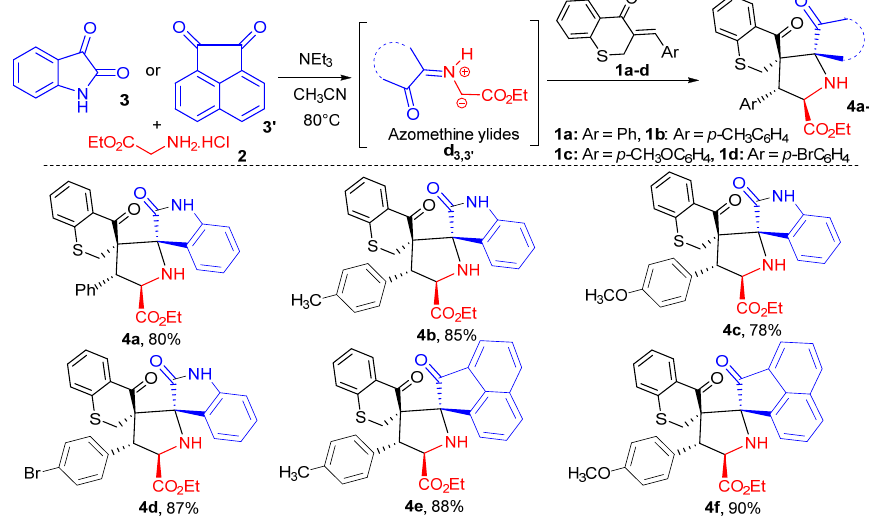
reaction using an oxygen surrogate, namely 5-arylidene chroman-4-ones 6, under the same reaction conditions (Table 2). same reaction conditions (Table 2). Table 1. Synthesis of spiropyrrolidine-thiochroman-4-ones hybrids 4. Table 1. Synthesis of spiropyrrolidine-thiochroman-4-ones hybrids 4 . Table 1. Synthesis of spiropyrrolidine-thiochroman-4-ones hybrids 4.